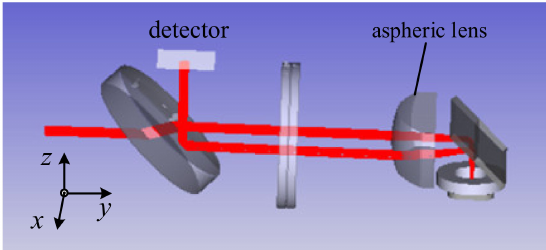
Figure 6. The layout of the Zemax